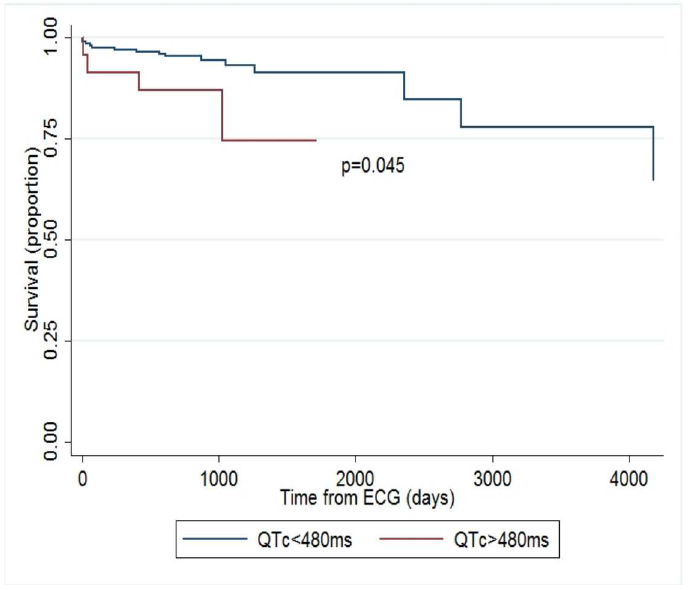
Fig 2. Kaplan-Meier survival curve, QTc of 480ms. Kaplan-Meier survival curves from time of ECG acquisition at the 90 th percentileof QTc (480ms) in the UIC cohort.